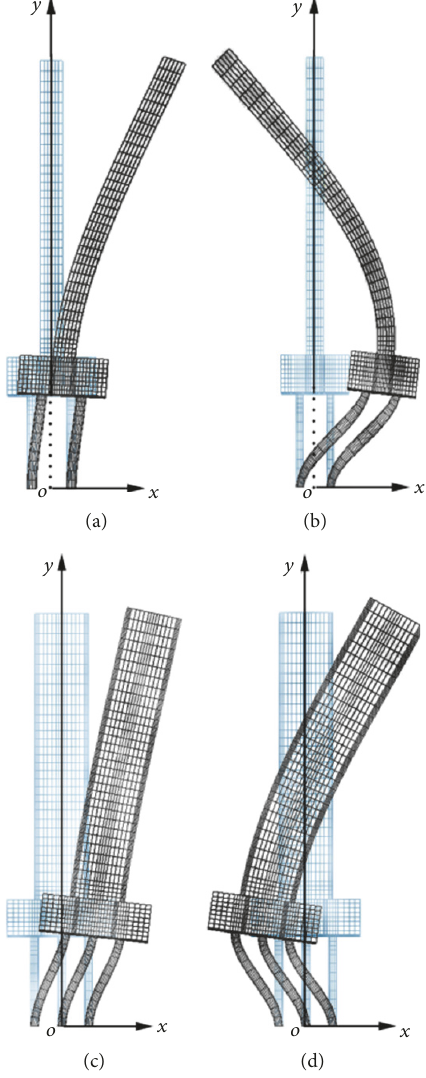
Figure11:Firstfourlateralmodeshapesofthedrystructurewithout tip mass: (a) first lateral mode along 𝑥 -axis; (b) second lateral mode along 𝑥 -axis; (c) first lateral mode along 𝑦 -axis; (d) second lateral mode along 𝑦